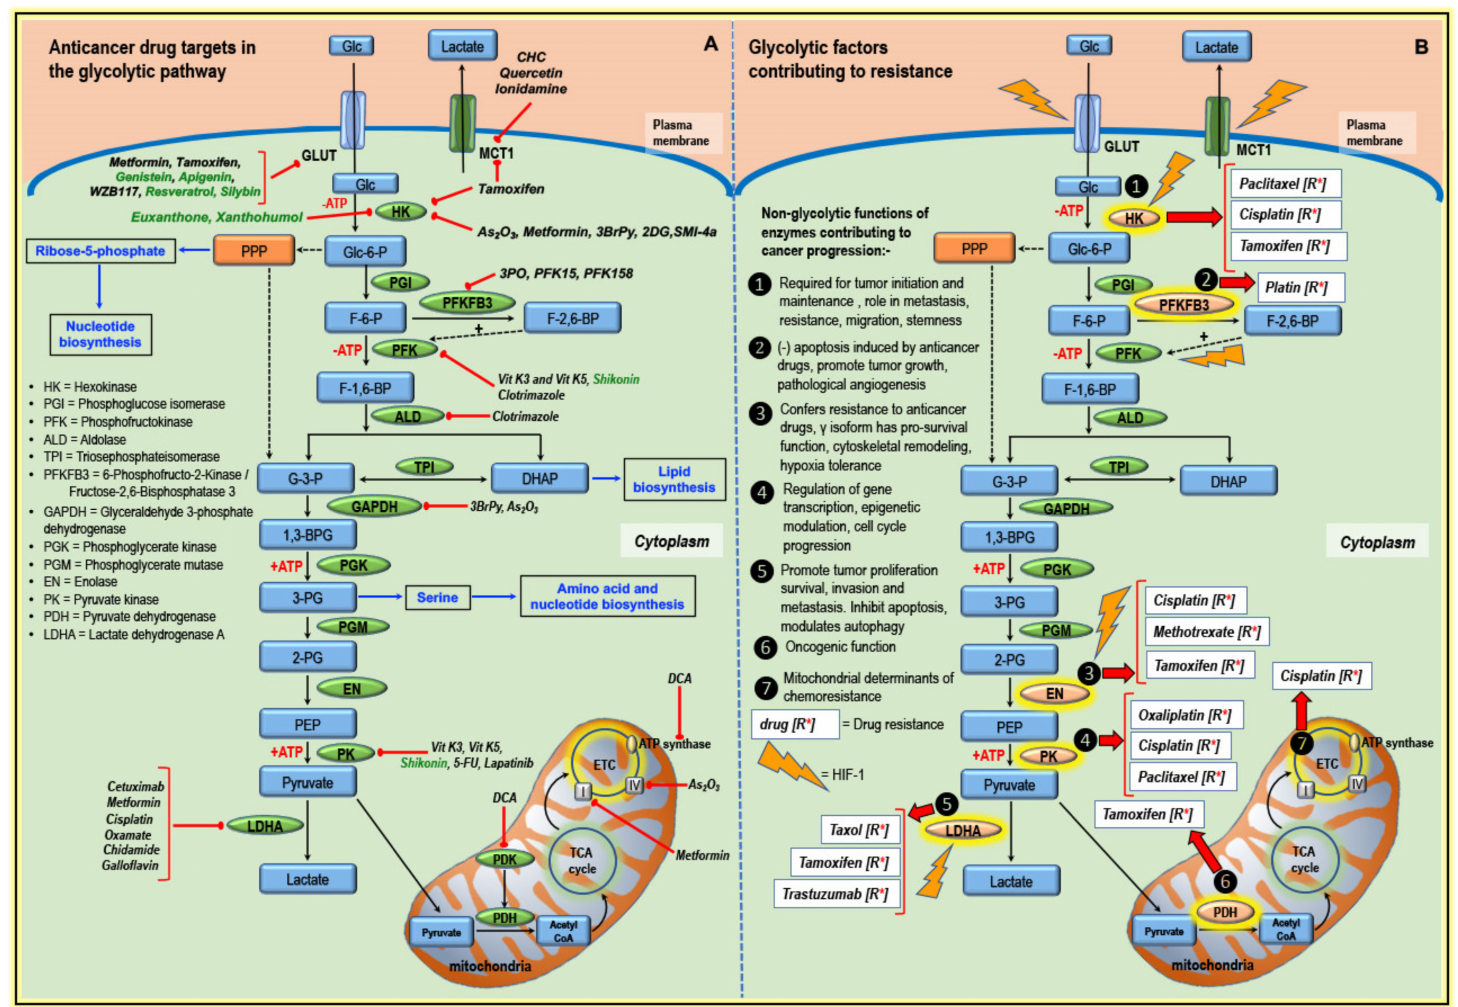
Figure 1. An illustration of glucose metabolism leading from the glycolytic pathway to the tricarboxylic acid cycle (TCA) and electron transport chain (ETC). ( A )